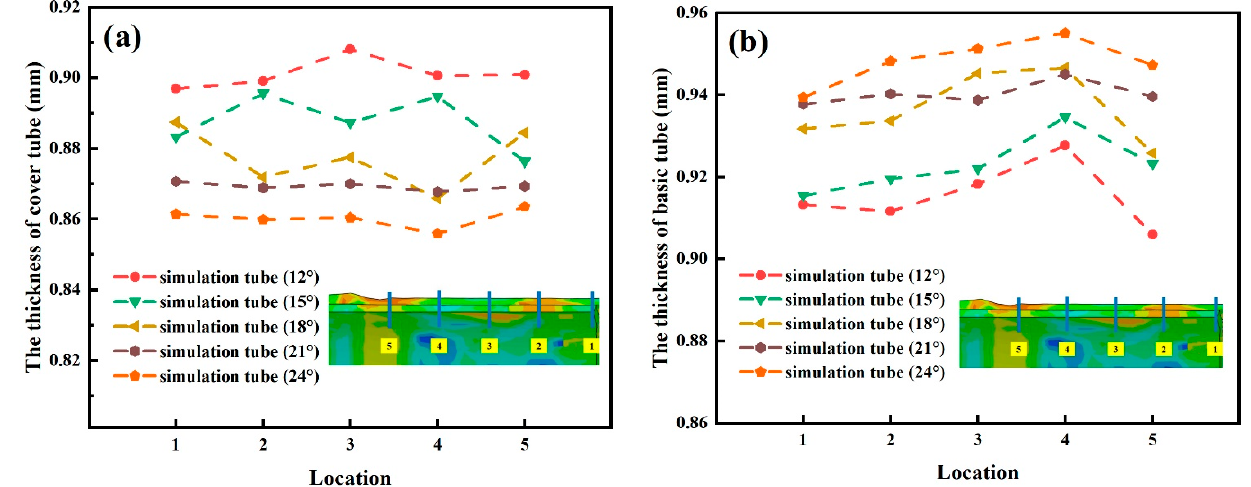
Figure 12. Simulated results of thickness after rotary ring spinning with different angles of attacks: ( a ) cover tube; ( b ) basic tube.